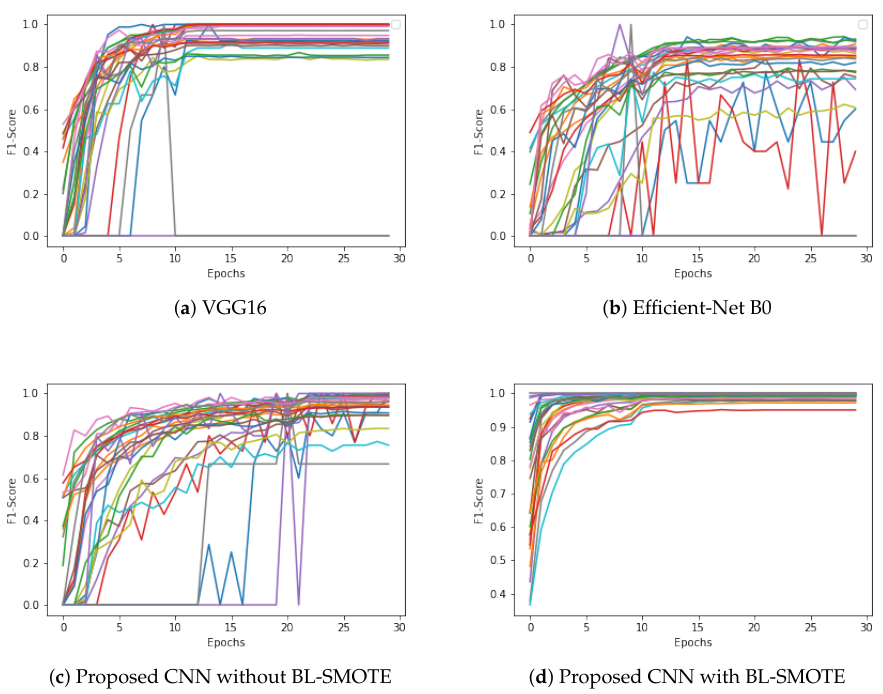
Figure 11. Calculate F1-score by taking the harmonic mean of a classifier’s precision and recall ( a ) VGG16, ( b ) Efficient-Net B0, and ( c , d ) proposed deep CNN model with and without